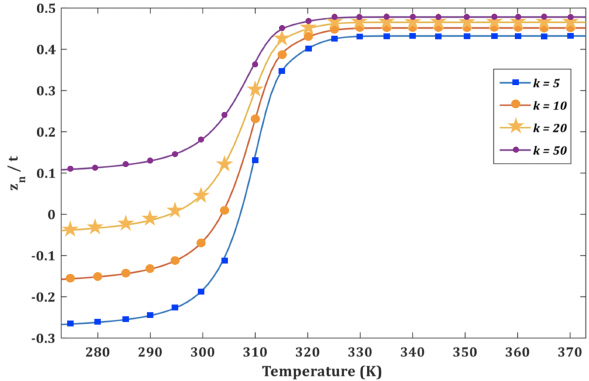
Figure 10: Variation of the position of the neutral strain surface z n / t with respect to temperature for various degree of bending, k ( m −1 )